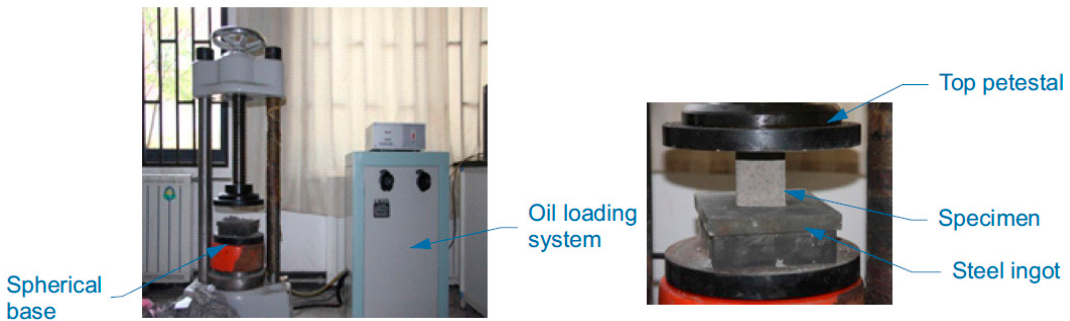
Figure 5. Uniaxial compressive strength (UCS) test of CPB samples.